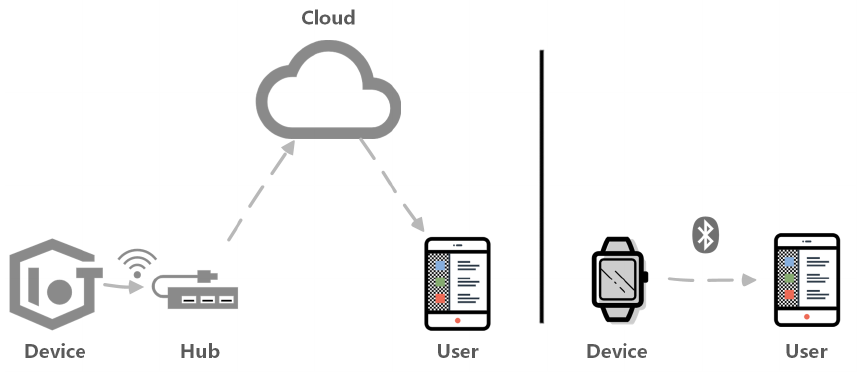
Figure 1. Internet of Things (IoT) architecture on the consumer-level.